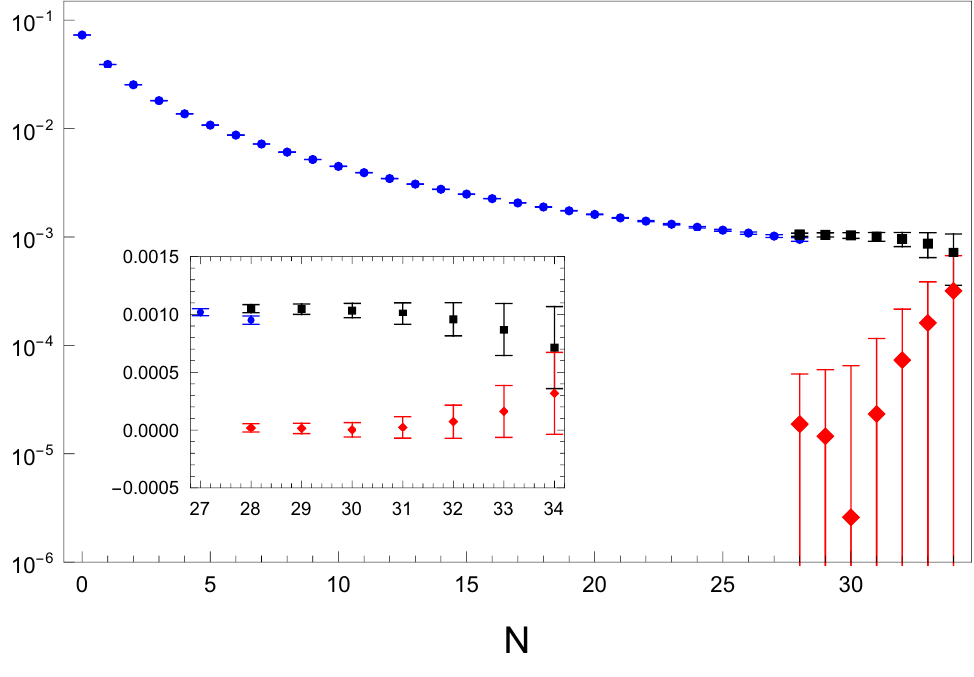
Figure 7 . We draw h P i MC (cid:0) P N